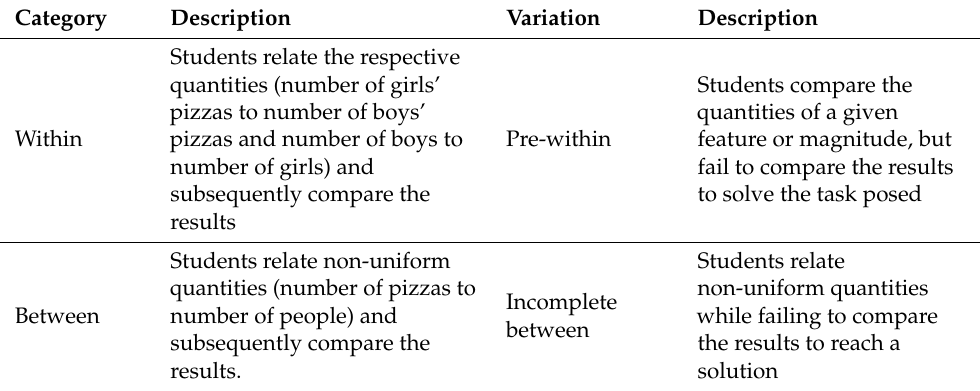
Table 3. Categories used to analyse